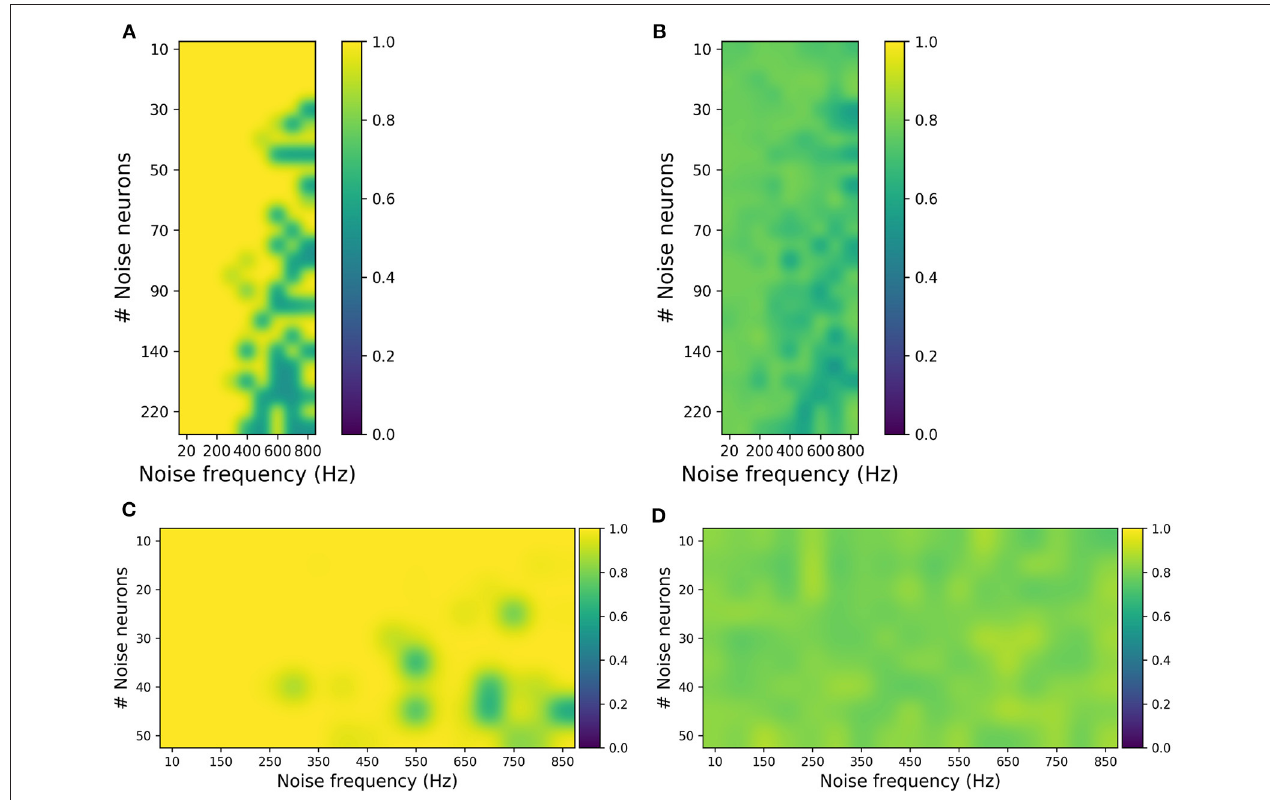
FIGURE 5 | Evaluating synthetic motor imagery (MI) and steady-state visually evoked potential (SSVEP) data generated from different combinations of the number of noise neurons and the firing frequency in the perturbation layer. (A,B) MI accuracy obtained by training the classifier with original data and testing with synthetic data ( A ) and vice versa ( B ). (C,D) SSVEP accuracy obtained by training classifier with original data and testing with synthetic data (C) and vice versa (D) . The highest accuracy in (B) is ∼ 80%, while the highest accuracy in (D) is 90%, which are close to the accuracies obtained when the original data are used for both training and testing the classifier.